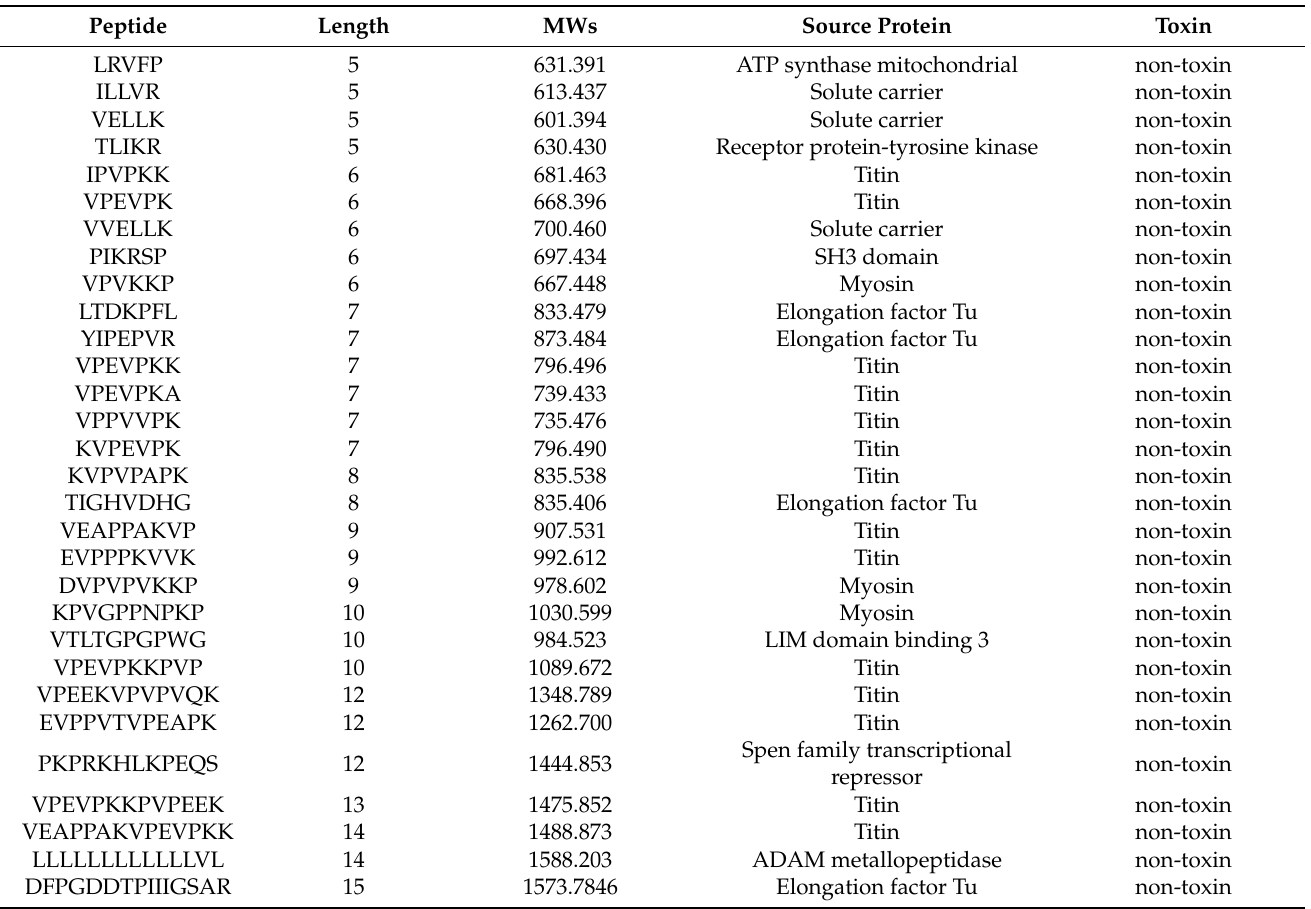
Table 1. Peptide sequences identified for the MIPF2 fraction in dry-cured pork